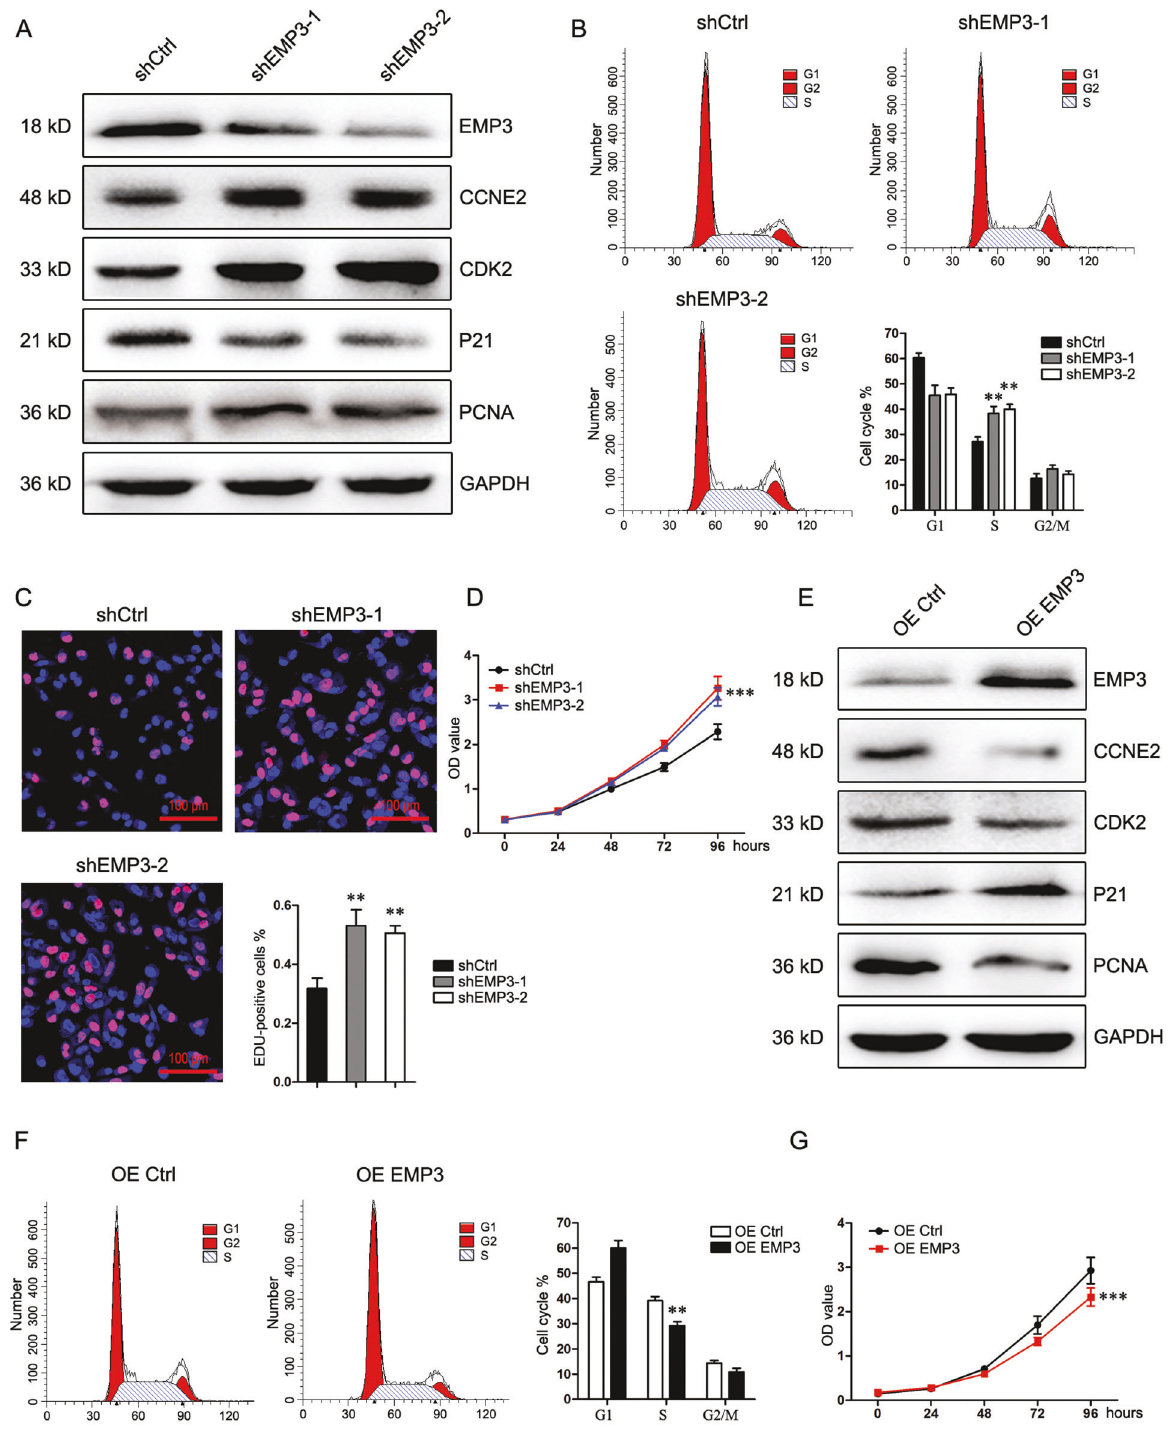
Fig. 2 EMP3 blocks S-phase entry and DNA replication. A EMP3, CCNE2, CDK2, P21, and PCNA expression in MDA-MB-231 cells was detected by western blot. B Cell cycle of MDA-MB-231 cells was analyzed by fl ow cytometry. Mean ± SD, n = 3. ** P < 0.01, vs. shCtrl. C DNA replication of MDA-MB-231 cells was analyzed by EDU staining. Mean ± SD, n = 3. ** P < 0.01, vs. shCtrl. D Viability of MDA-MB-231 cells was analyzed by CCK8. Mean ± SD, n = 3. *** P < 0.001, vs. shCtrl. E EMP3, CCNE2, CDK2, P21, and PCNA expression in MCF7 cells was detected by western blot. F Cell cycle of MCF7 cells was analyzed by fl ow cytometry. Mean ± SD, n = 3. ** P < 0.01, vs. OE Ctrl. G Viability of MCF7 cells was analyzed by CCK8. Mean ± SD, n = 3. *** P < 0.001, vs. OE and survival. Therefore, the effect of EMP3 on Akt-mTor EMP3 inhibits Akt-mTor signaling and induces autophagy signaling was investigated. EMP3 knockdown induced the Intracellular signaling related to EMP3 was unknown in breast phosphorylation of Akt, P70, and mTor in MDA-MB-231 cells; cancer. Akt-mTor signaling has a critical role in tumor cell growth